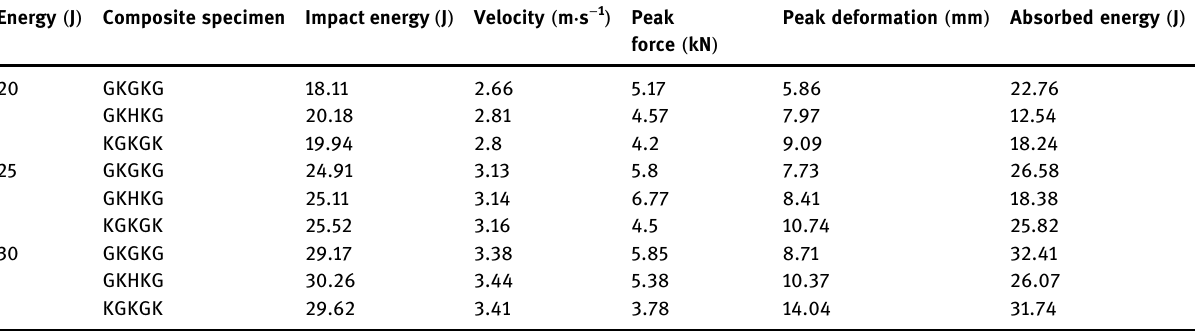
Table 2: A data from low - velocity impact testing Energy ( J ) Composite specimen Impact energy ( J ) Velocity ( m · s − 1 )